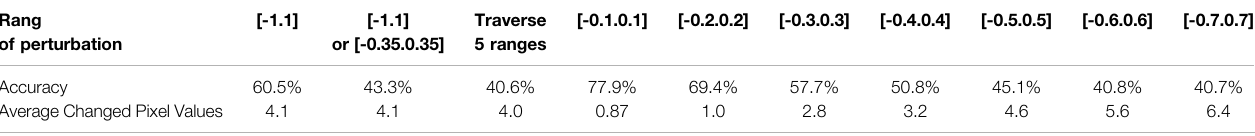
TABLE 2 | All eight results of getting 1 cell stuck at minimum/maximum conductance. 10 perturbations occur in the range of [-1.1] and the remaining ranges have 20 perturbations.